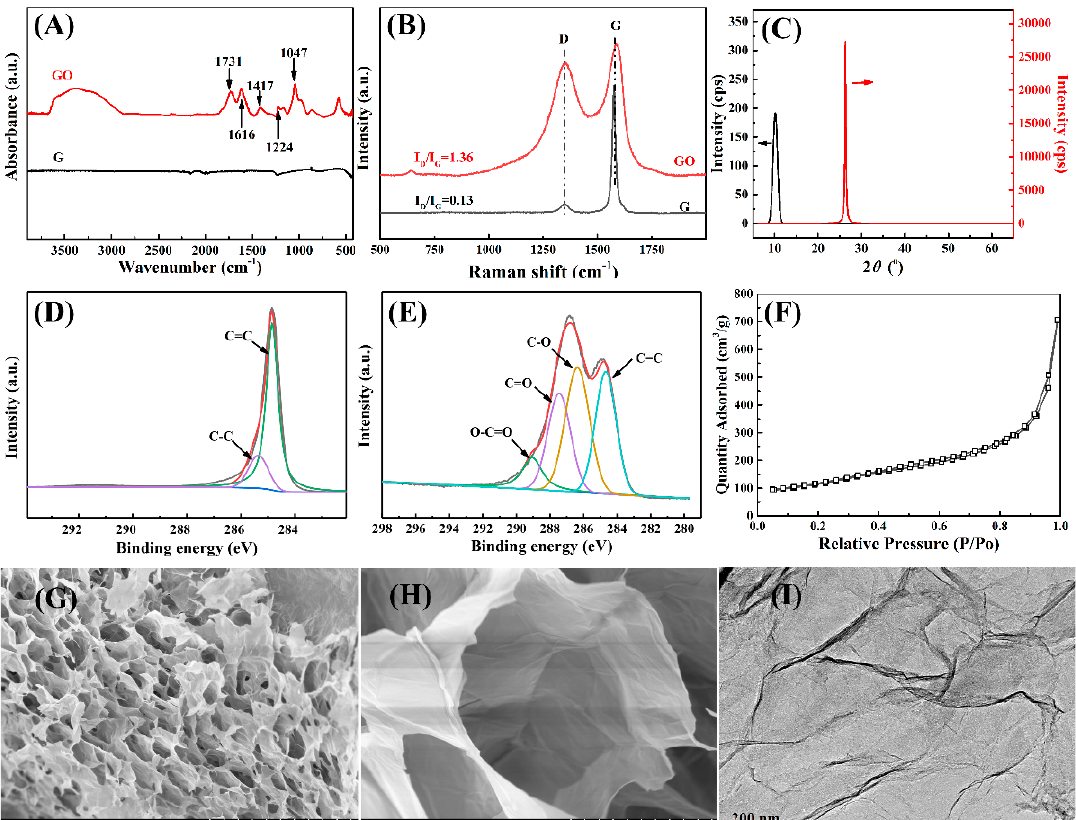
Figure 3. Characterizations of graphene ( G ) and GO: ( A ) FTIR spectra; ( B ) Raman spectra; ( C ) XRD patterns (the black line is GO, the red line is graphene); high–resolution C 1s XPS spectra of ( D ) graphene and ( E ) GO; ( F ) nitrogen adsorption–desorption curve of GO obtained from BET test; ( G ) and ( H ) SEM images of GO; and ( I ) TEM image of GO. Reprinted with permission from [41]. Copyright @Springer–Nature.